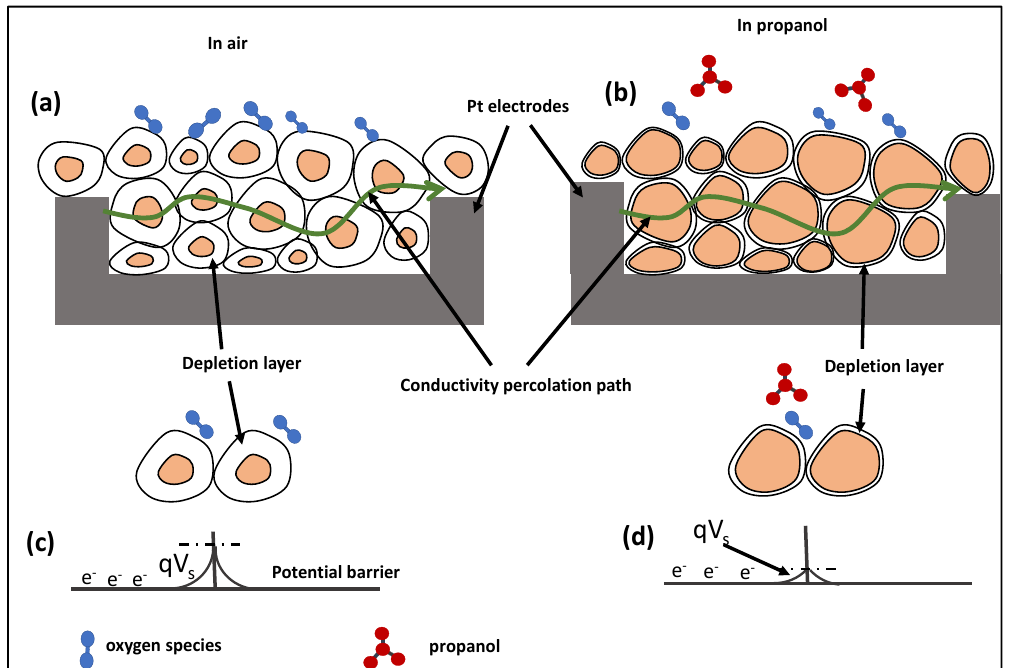
Figure 10. ( a , b ) Gas sensing mechanism of ZnFe 2 O 4 NP sensing layer showing depletion layer in the presence of oxygen without propanol and in the presence of oxygen with propanol, respectively. ( b – d ) Charge transport of the sensing layer in the presence of oxygen without propanol and in oxygen with propanol, respectively.